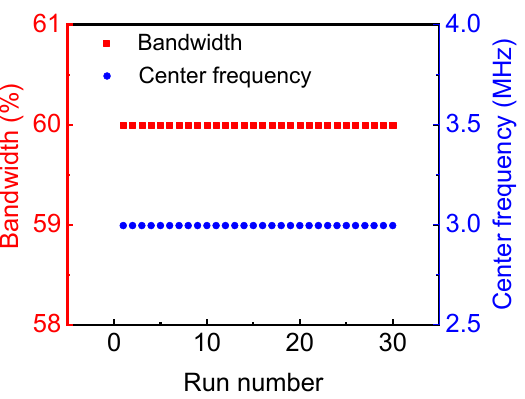
Figure 6. Performance parameters of ultrasonic transducer obtained at the optimized design parameters. Table 2. Value of design parameters.